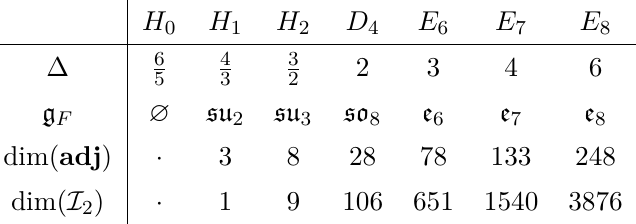
Table 1 . Data for the rank 1 N = 2 ‘exceptional’ superconformal theories. Here ∆ is the dimension of the Coulomb branch operator and g is the flavor F